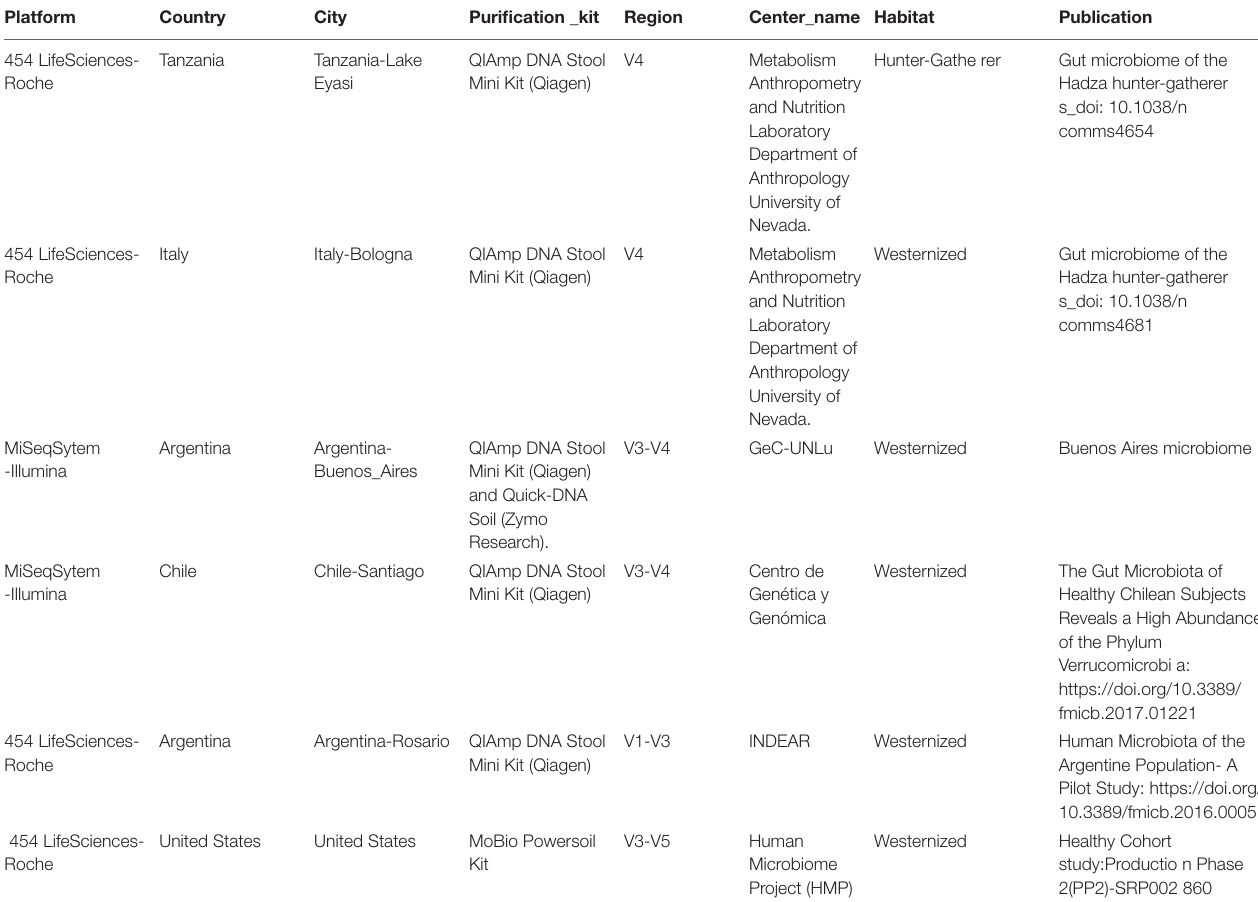
TABLE 2 | Data-sets included in the